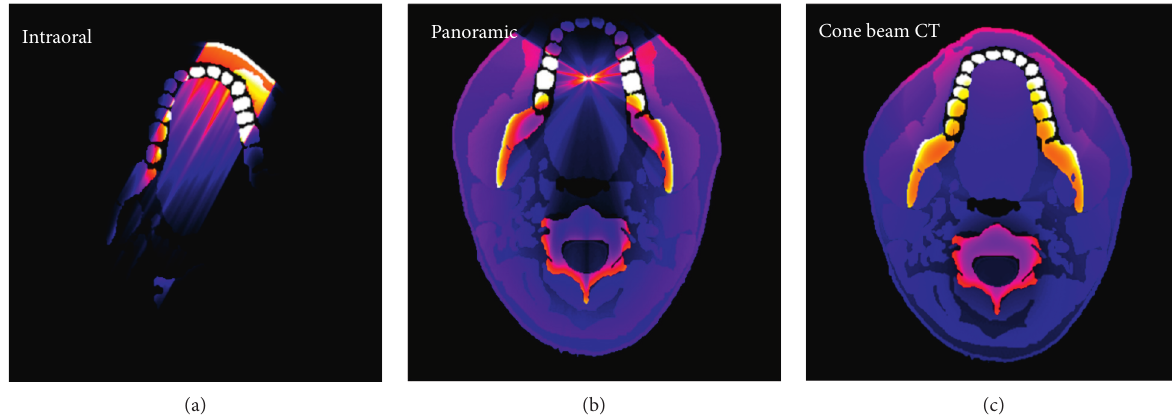
Figure 2: Dose distribution at the level of the lower teeth generated by MC-GPU simulations for (a) intraoral radiography, (b) panoramic radiography, and (c) cone-beam computed